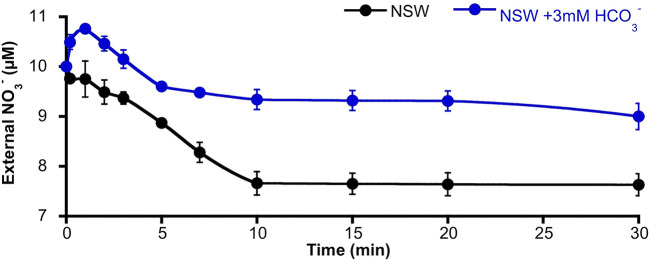
Time course of the external nitrate concentration around Posidonia oceanica leaf pieces incubated in NSW. Plants were previously incubated in NSW containing 100 µM NO3−, then excised leaves were incubated in NSW (black trace, control condition) or NSW supplemented with 3 mM HCO3− (blue trace). At different times within the first 30 min of incubation, samples were taken and used to determinate external NO3− concentration. Data are mean ± SD of six independent assays. Mean values, net efflux, and influx NO3− rates and statistics are indicated in the text.